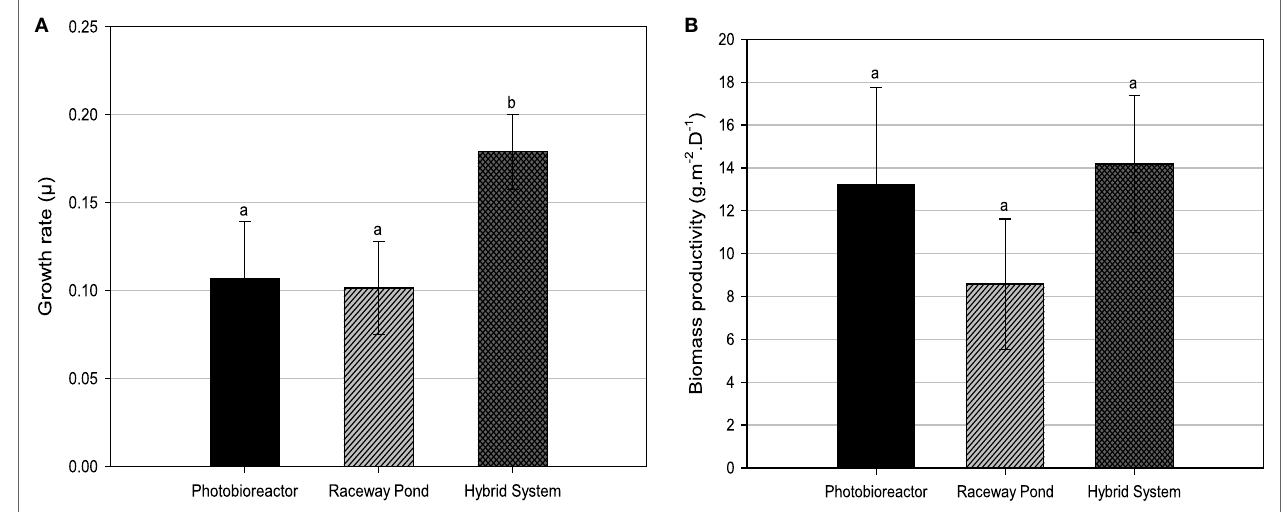
FigUre 6 | (a) Growth rates and (B) biomass productivities for different cultivation systems . Different letters show statistically significant differences ( P <